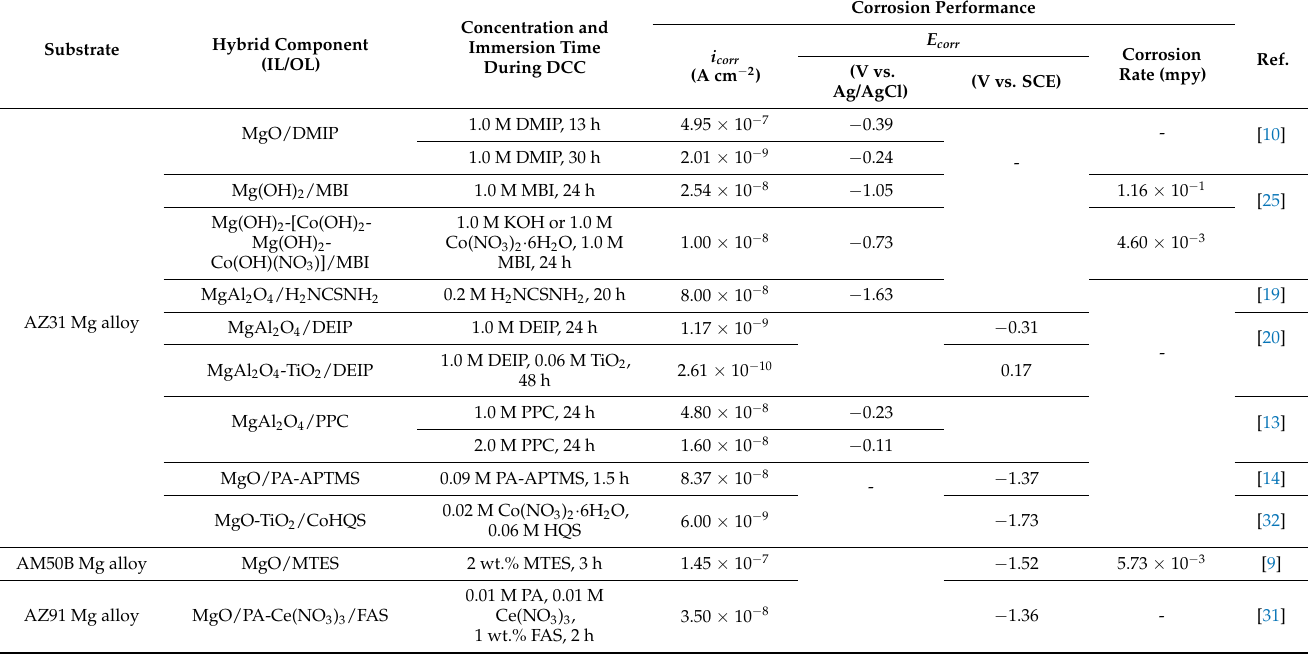
Table 1. Corrosion performance of HOI coating-based Mg alloy comprising various hybrid components in 3.5 wt.% NaCl. Concentration and Immersion Time Substrate Hybrid Component (IL/OL) During